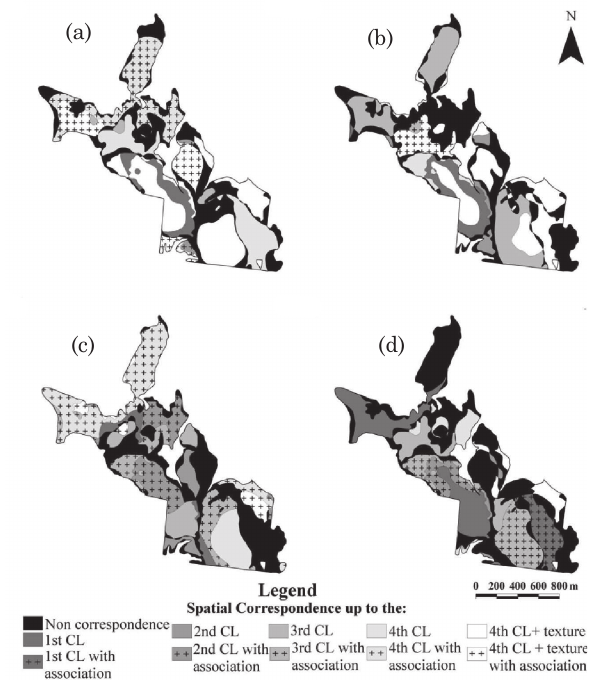
Figure 6. Spatial agreement maps between soil maps: a) Digital and A; b) Digital and B, c) Digital and C; and d) Digital and D.